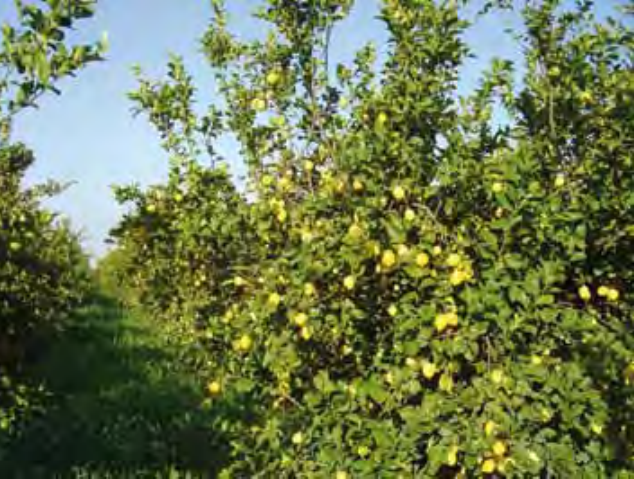
Fig. 7 - ‘Femminello’ lemon